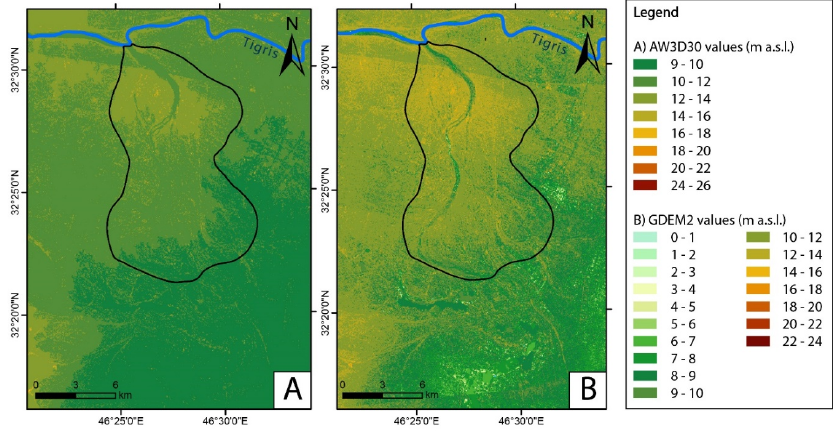
Figure 7. Example of the differences between the altimetric configuration of crevasse C10 as visualized using the AW3D30 ( A ) and GDEM2 ( B ) datasets.